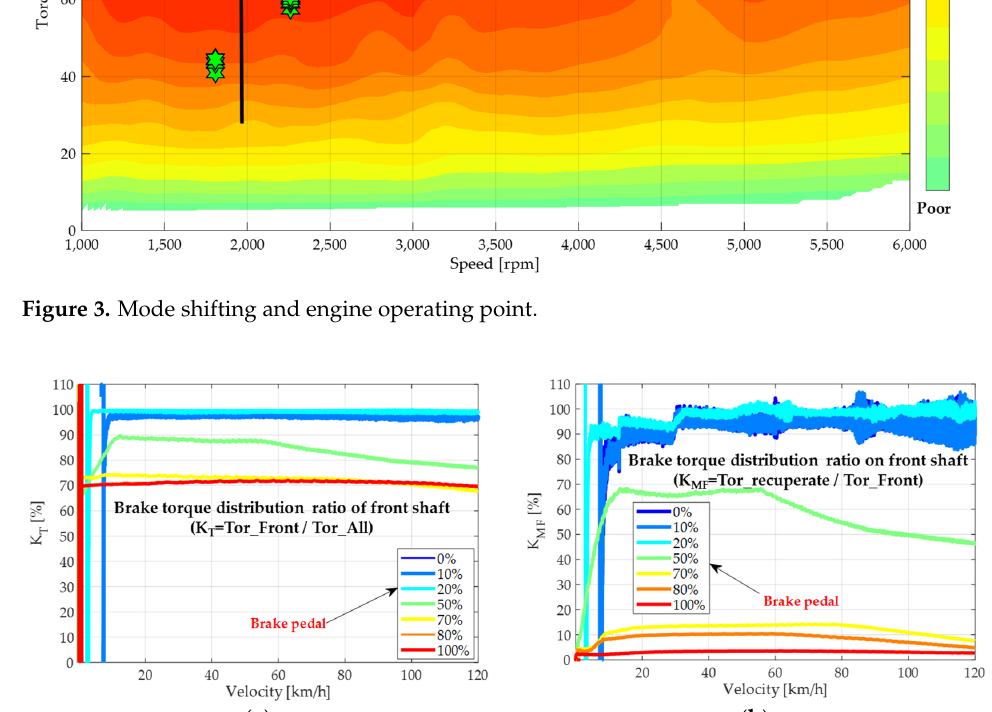
Figure 3. Mode shifting and engine operating point.